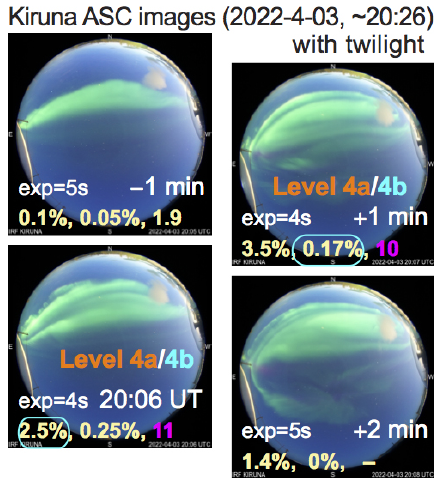
Figure 12. ASC images around 20:06UT on 3 April 2022, when the ASC auroral index values did not reach Level 6 due to the twilight effect when the local-arc breaking took